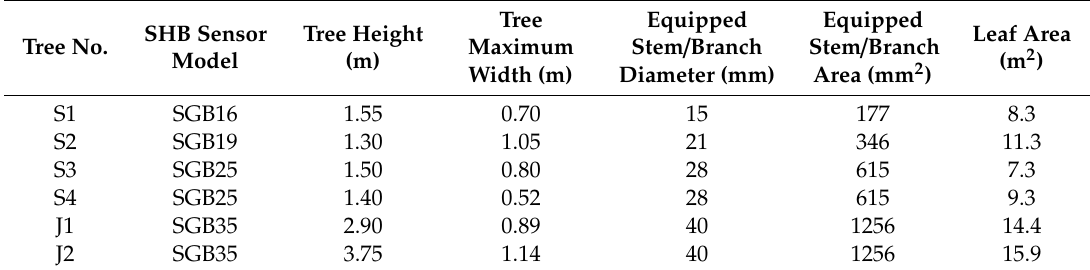
Table 1. Sensor information and characteristics of sapling and juvenile juniper. Tree height, tree maximum width, and equipped stem / branch diameter were measured. Equipped stem / branch area and leaf area were computed. SHB Tree No.